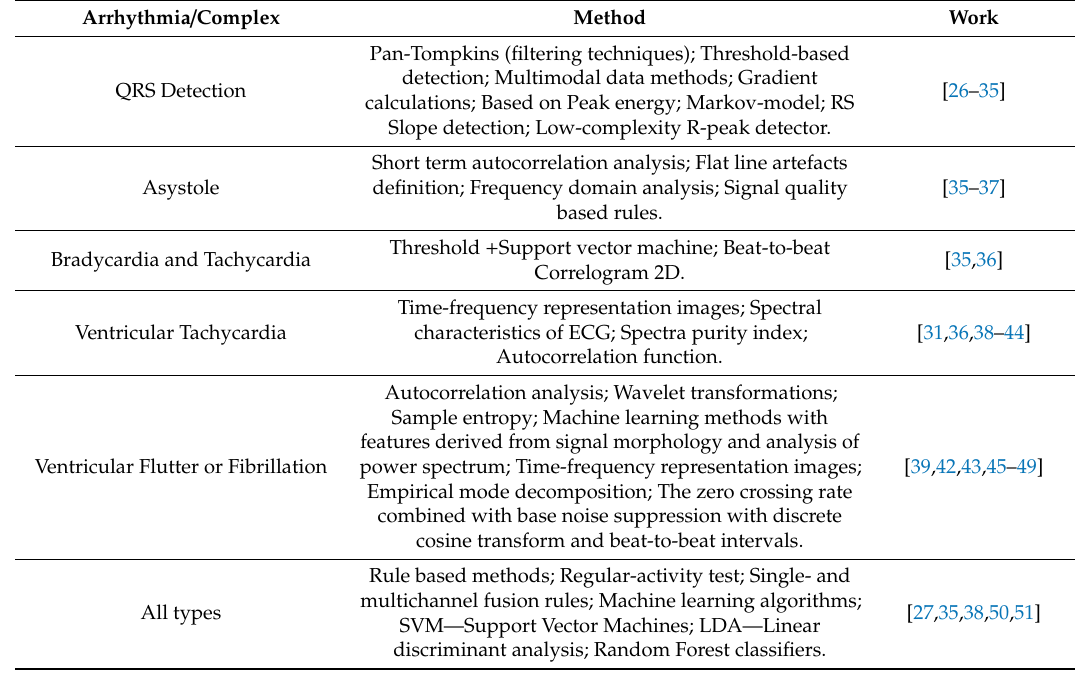
Table 2. Methods of detecting